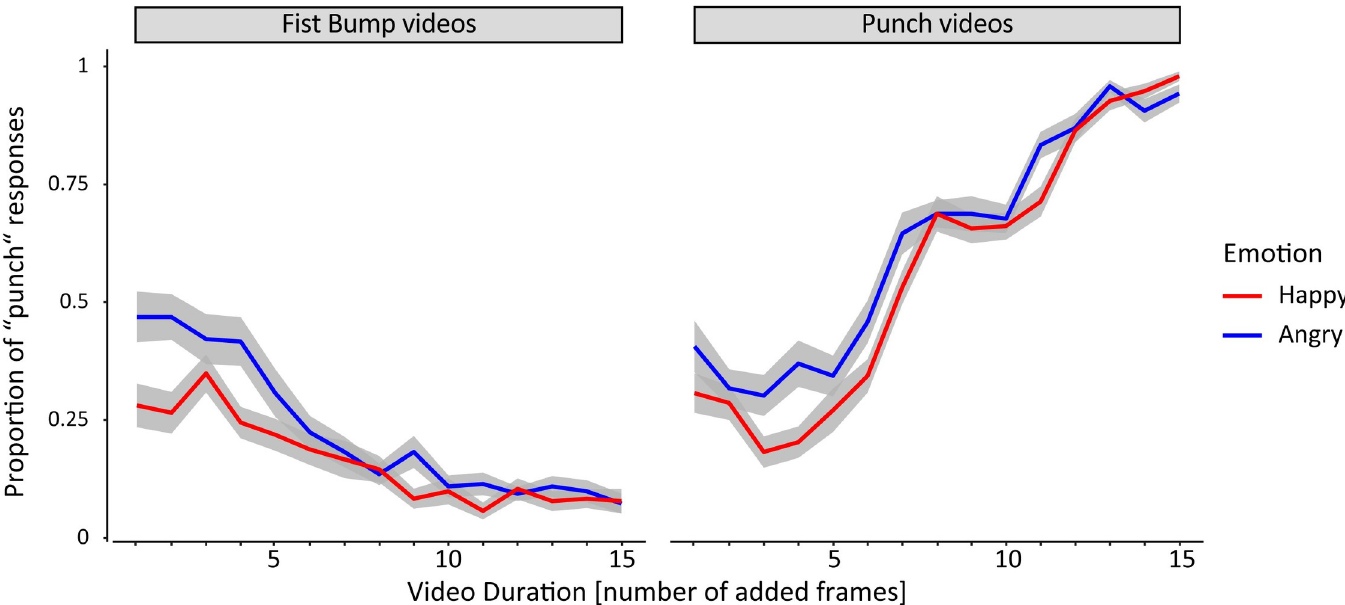
Fig 3. Action judgments as a function of action, facial emotion and video duration. Proportion of punch responses for different facial emotions (angry, happy), separately for the two different actions (fist bump, punch), as a function of video duration in number of added frames. Shaded areas depict the standard error of the mean.